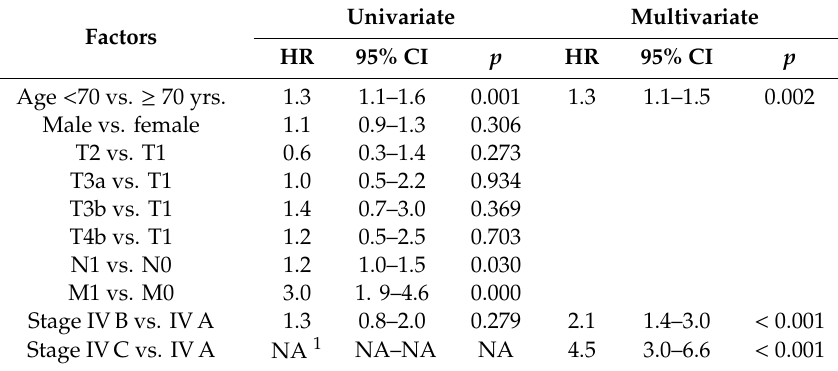
Table 6. Multivariate analysis of the factors influencing overall survival of the ATC patients according to the AJCC / UICC TNM classification, 8th